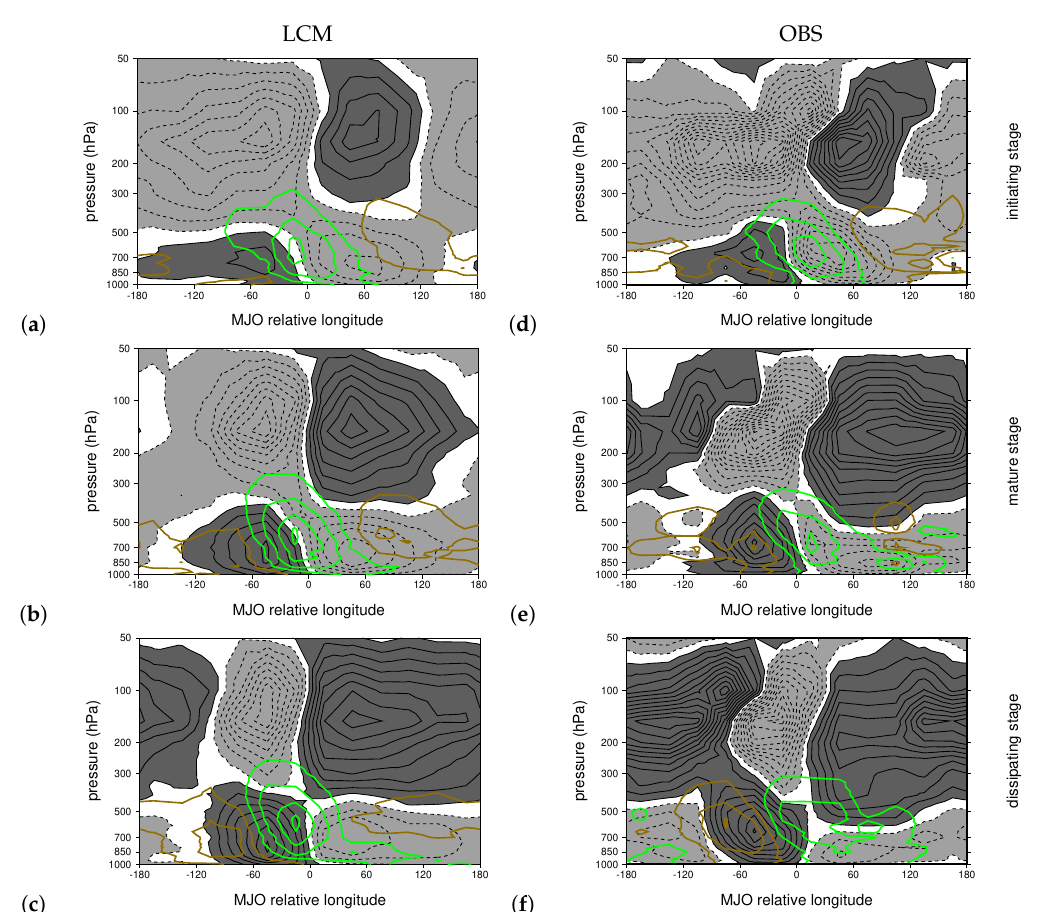
Figure 6. Comparison of observed and modeled composite vertical structure of moisture and zonal wind of the MJO. ( a – c ) Initiating, mature, and dissipating stages in the LCM respectively for the first 30 years of the simulation. ( d – f ) Initiating, mature, and dissipating stages of the observed MJO respectively (from [6]). Zonal wind is contoured in black with a 0.5 m/s contour interval, with values greater than (less than) 0.25 m/s ( − 0.25 m/s) shaded dark (light) gray. Positive (negative) moisture perturbations are shown in green (brown) with a 0.2 g/kg contour interval ( − 0.7, − 0.5, − 0.3, − 0.1, 0.1, 0.3, 0.5, 0.7